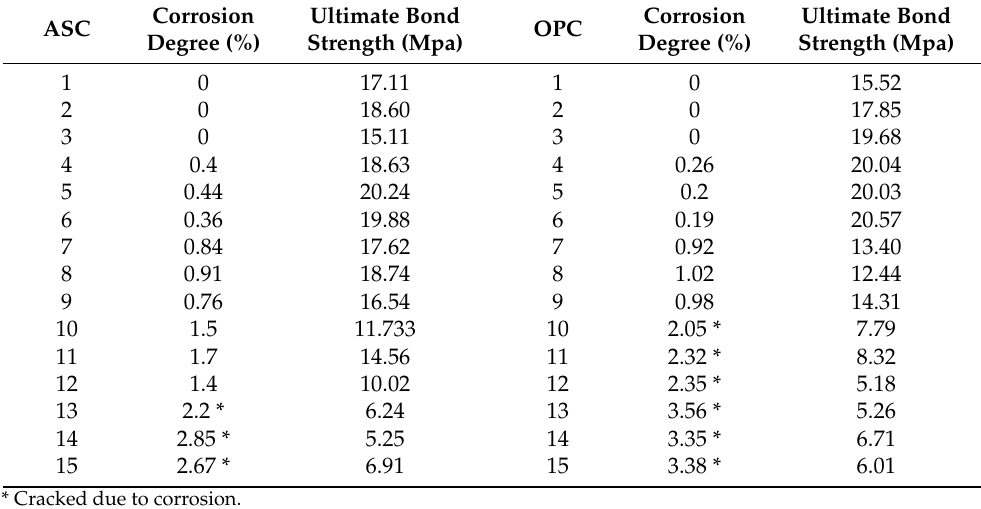
Table 6. Corrosion degree and ultimate bond strength of OPC.